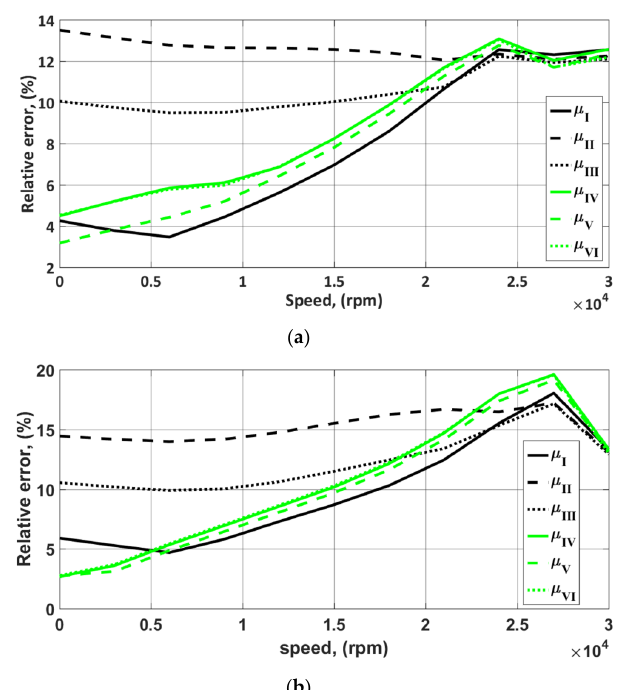
Figure 4. Variation of relative error (9) vs. rotational speed using various methods of calculating the e ff ective magnetic permeability for the RMS phase supply equal to: 50 V ( a ), and 75 V ( b